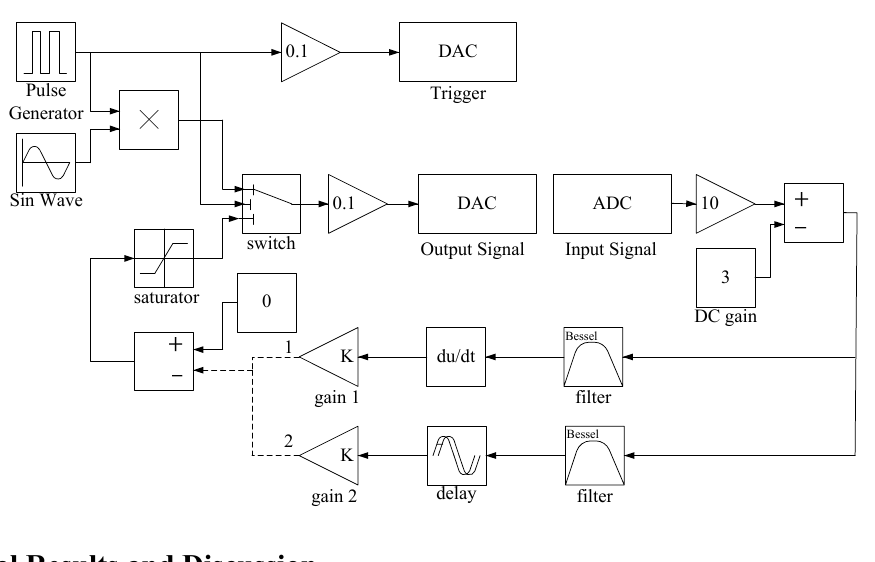
Figure 2. Simulink program for active vibration